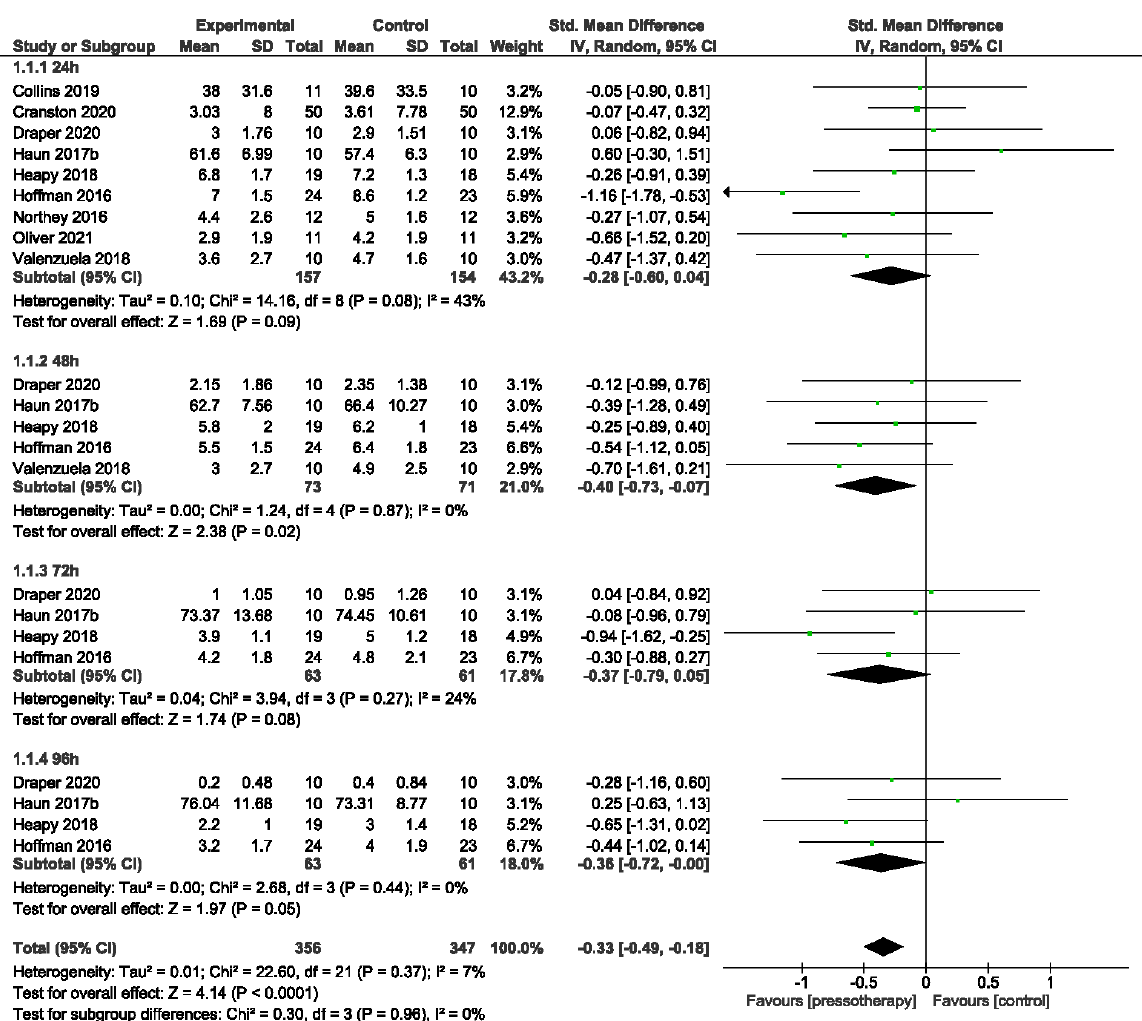
Figure 4. Effects of pressotherapy on muscle soreness from 24 h to 96 h after exercise.